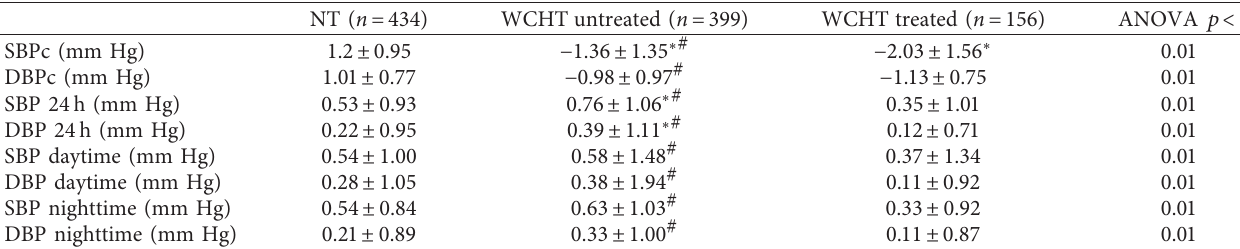
Table 3: Annual evolution of BP (mm Hg/year) during the